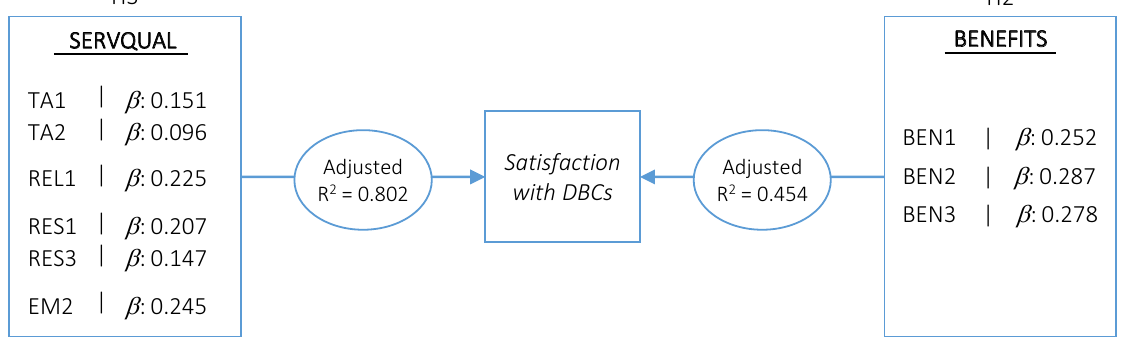
Figure 2. Regression SERQUAL and benefits on satisfaction with